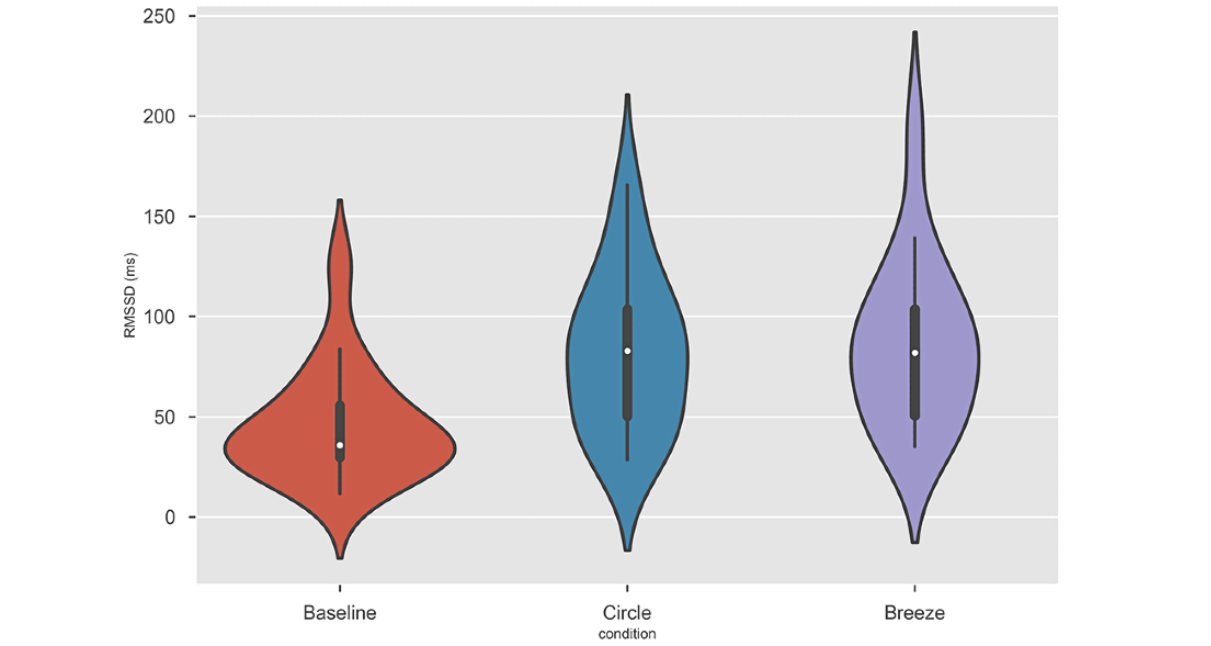
Figure 7. Violin plots depicting the distribution of the root mean square of the successive differences (RMSSD) measurements in all the 3 conditions. Each violin plot’s outer shape represents the complete distribution of the sample. In addition, standard boxplots with the medians represented by white points are